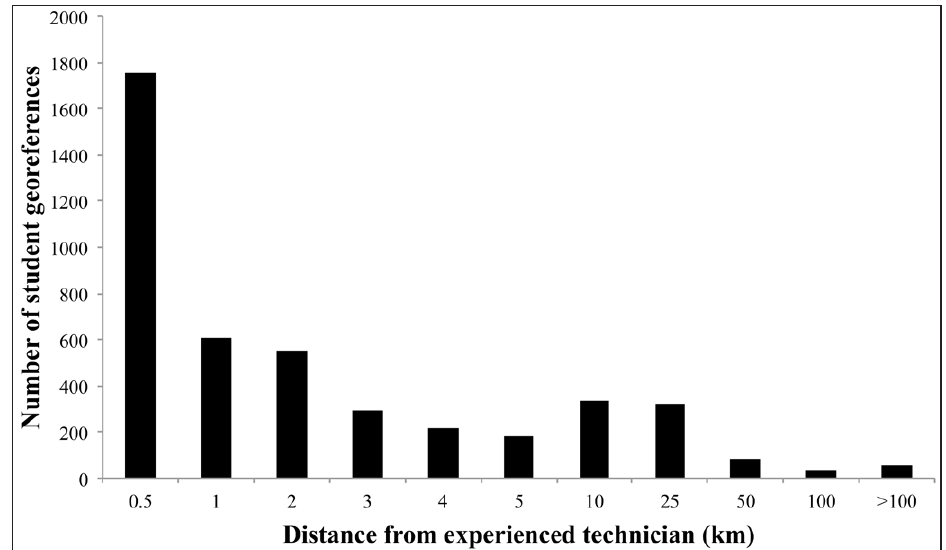
Figure 2: Distribution of the distance of student georeferences from expert points in the fish experiment at Tulane University with outliers